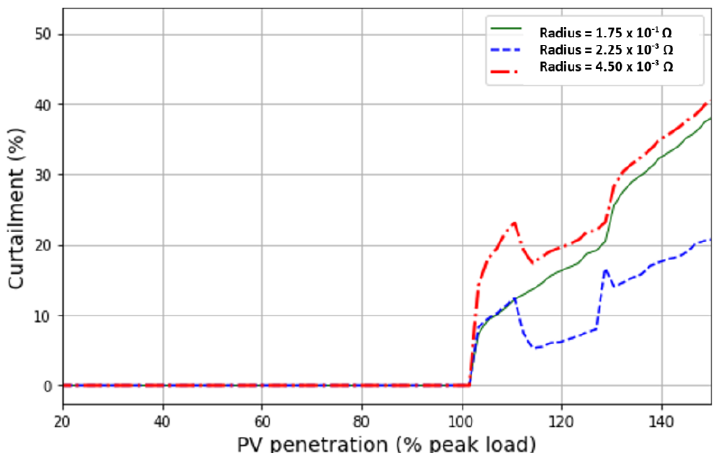
Figure 9. Comparison of aggregate PV energy curtailments for three curtailment radius values.